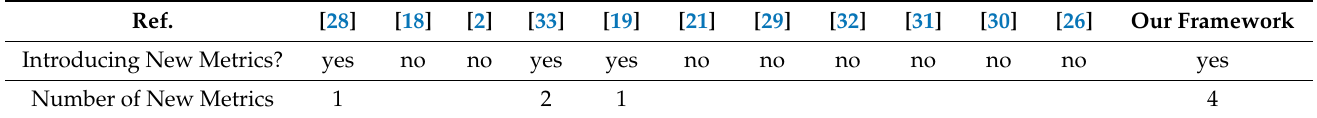
Table 14. Comparative table of new introduced metrics. Ref.